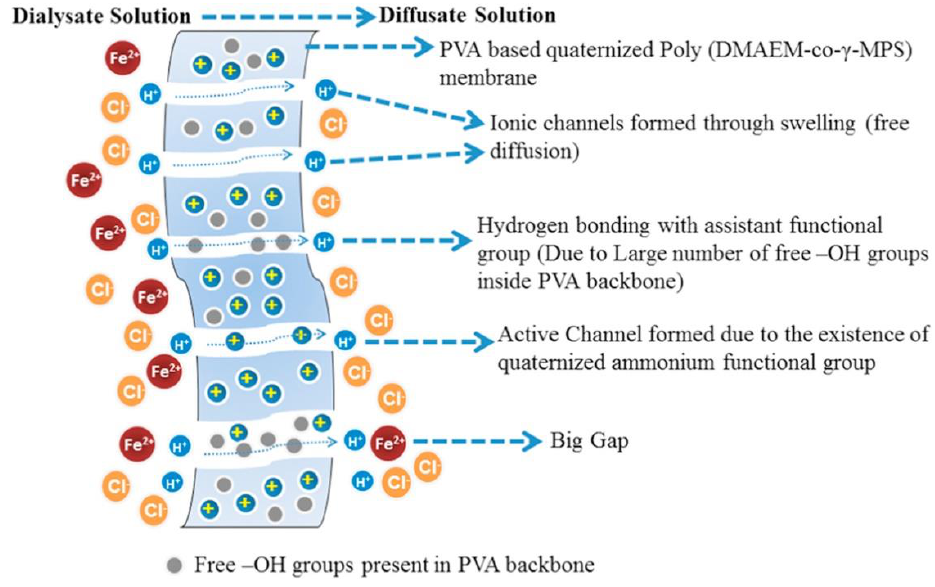
Figure 4. Schematic diffusion dialysis process. Reprinted from Reference [66] with permission from Elsevier.